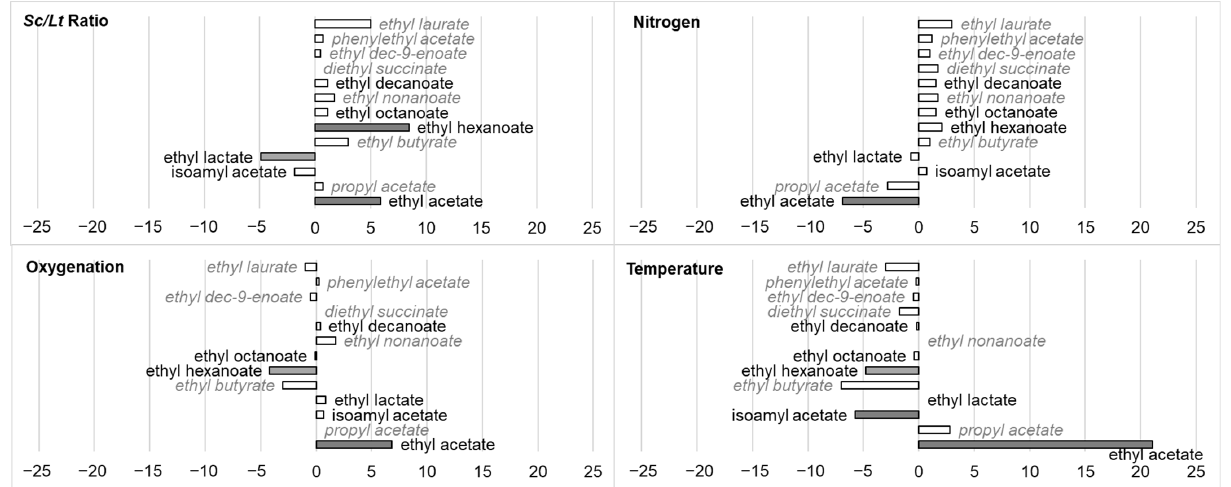
Figure 6. Impact (standardized effects) of fermentation parameters ( Sc / Lt ratio, nitrogen, oxygenation, temperature) on the production of different esters. Data are identified as statistically almost significant (0.05 < p -value < 0.1, light grey), significant ( p -value < 0.05, grey), or very significant ( p -value < 0.01, dark grey). Compounds in italics and in grey were only present in trace amounts, with values too low to perform a relevant statistical test.